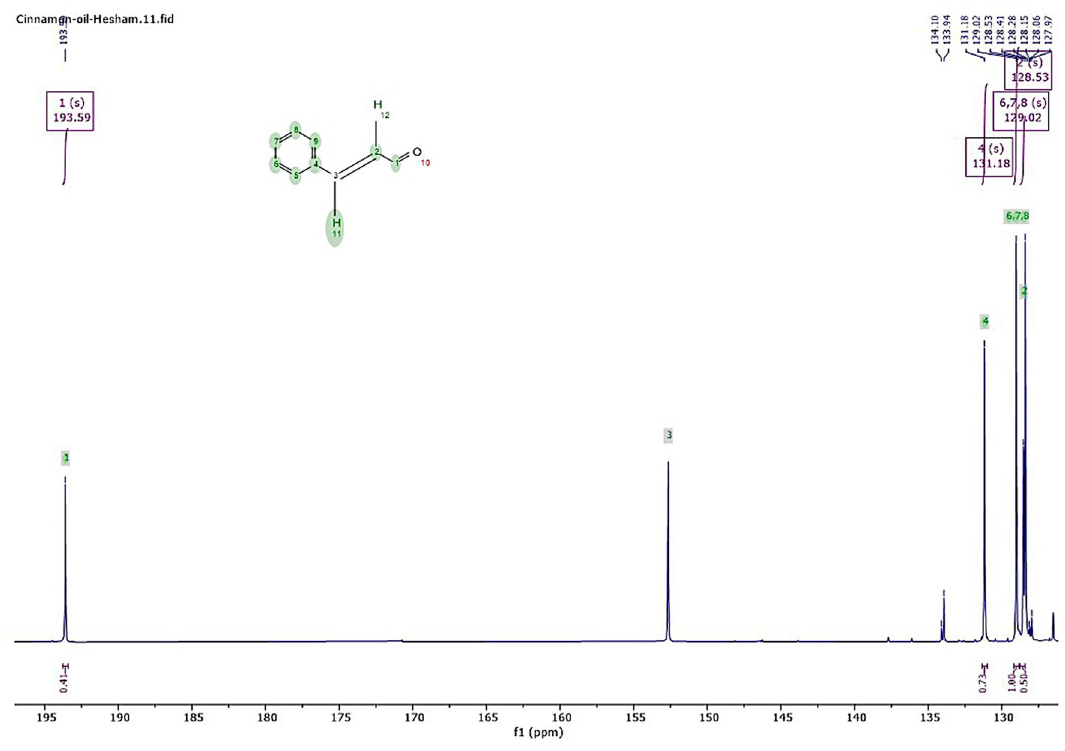
Figure 4. 13 C NMR spectrum of